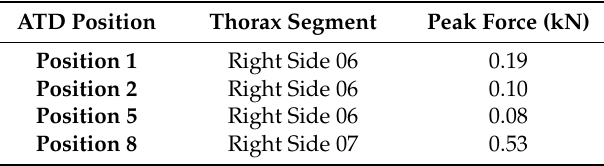
Table 12. Peak thoracic force and pressure from right thorax to centre console impact.